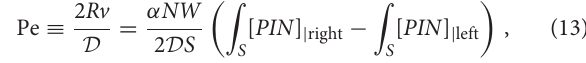
1) or high sensitivity ( R ≃ ≫